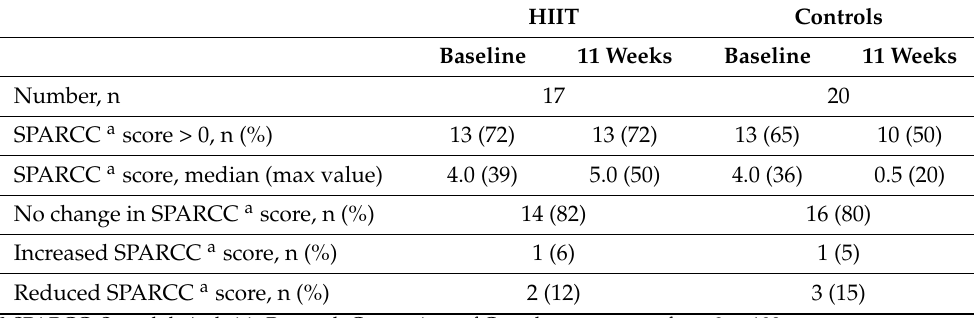
Table 3. Results from evaluation of short tau inversion recovery MR images of the participants in high intensity interval training (HIIT) and controls groups at baseline and after 11 weeks by SPARCC scoring [26]. If SPARCC score changed by five or more to week 11, it was categorized as increased or decreased according to minimally important changes [40]. Number of participants with detectable changes after 11 weeks were not significantly different for the two groups (Fisher’s Exact Probability Test p -value: 1).